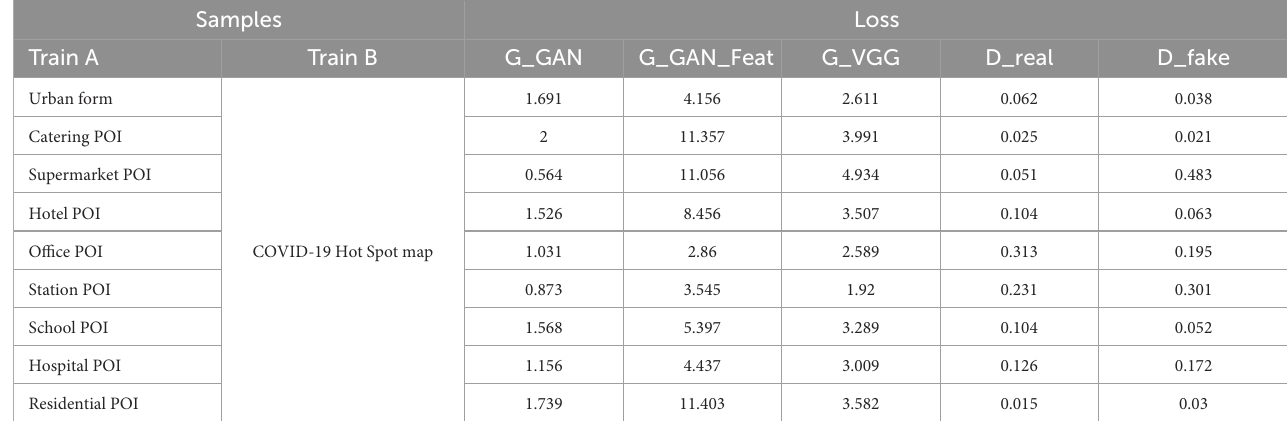
TABLE 2 Model training